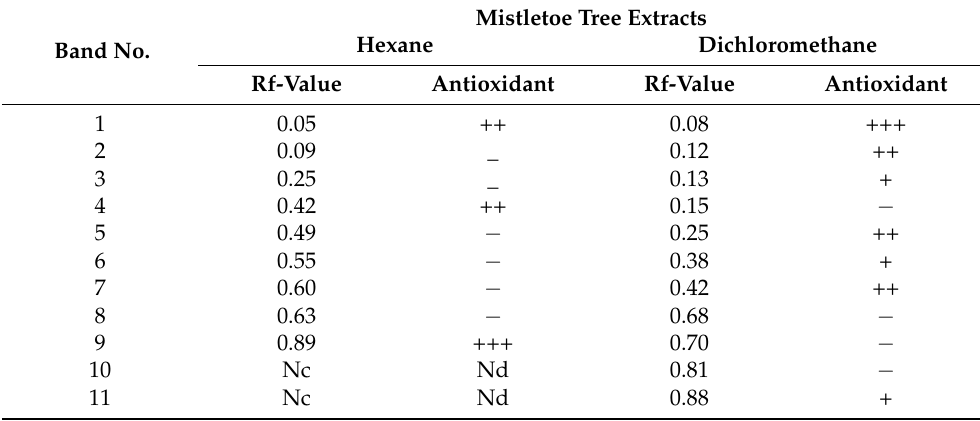
Table 2. Phytochemical bands and their antioxidant potentials in the non-polar hexane and di- chloromethane extracts of Mistletoe tree. Mistletoe Tree Extracts